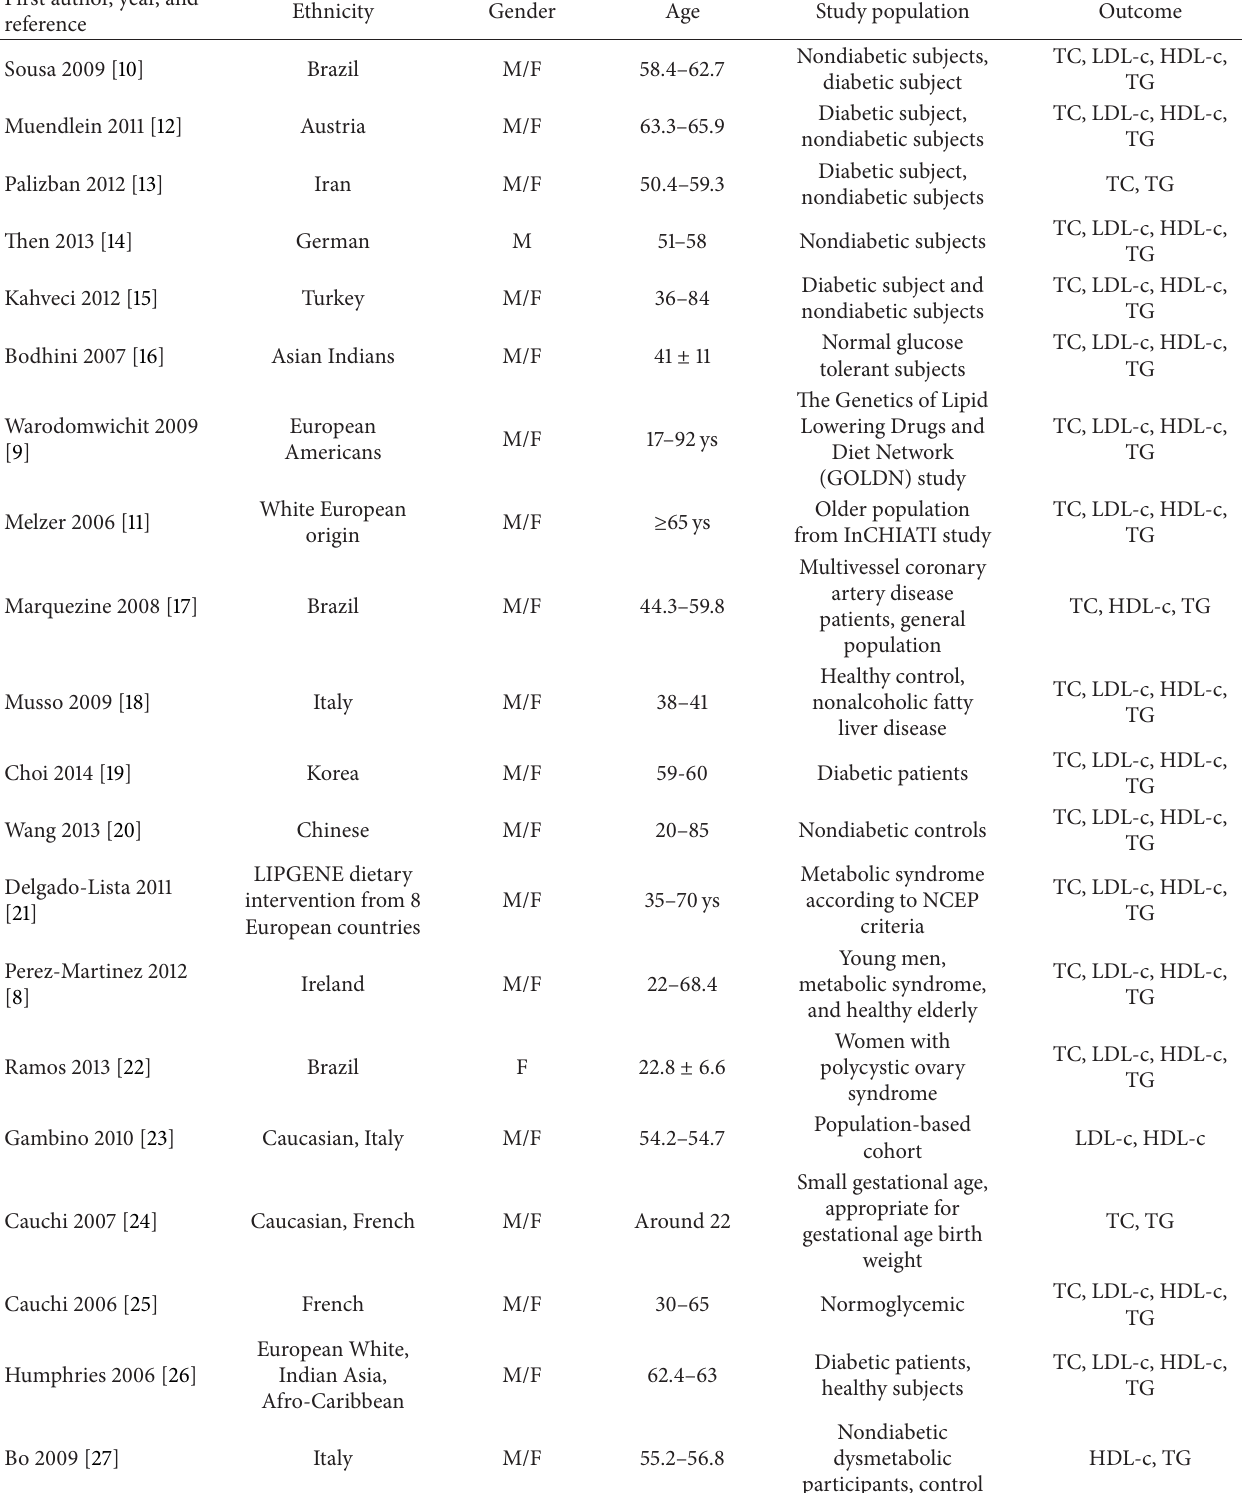
Table 1: Characteristics of the study populations in the included